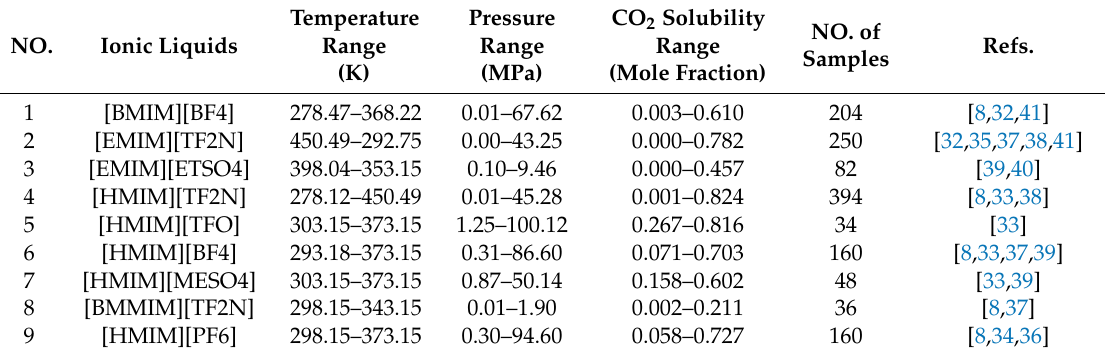
Table 3. Solubility data of CO 2 in di ff erent imidazolium ionic